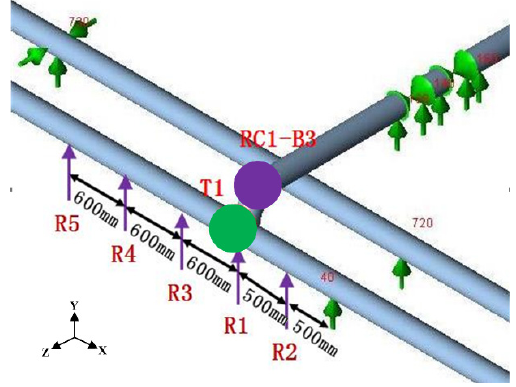
Figure 17. Constraint positions near T1.